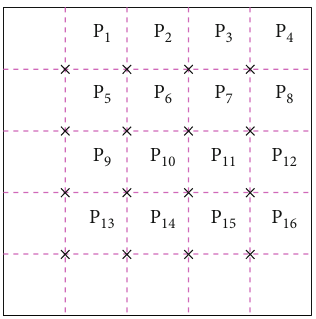
Figure 4: Measuring points at a cross-section for temperature